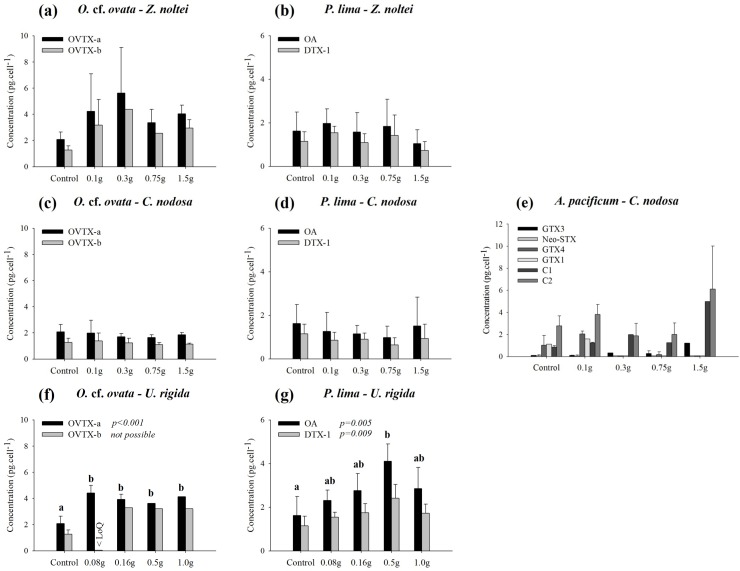
Cellular toxin contents (pg.cell-1) at the end of the experiments (after 10 days) of Ostreopsis cf. ovata (O. cf. ovata) and Prorocentrum lima (P. lima) in presence of the leaves/thalli of Cymodocea nodosa (C. nodosa), Zostera noltei (Z. noltei) and Ulva rigida (U. rigida), and of Alexandrium pacificum (A. pacificum) in presence of C. nodosa leaves.OVTX-a: Ovatoxin-a; OVTX-b: Ovatoxin-b; OA: Okadaic Acid; DTX-1: Dinophysistoxin-1; Neo-STX, GTX1, GTX3 and GTX4: Carbamoyl toxins; C1 and C2: N-sulfocarbamoyl toxins. ‘< LoD’ and ‘< LoQ’ indicate ‘< Limit of Detection’ and ‘< Limit of Quantification’, respectively. Error bars correspond to the standard deviation (N = 3 replicates, except for control (O. cf. ovata and P. lima) for which the controls of the three experiments have been pooled, N varying between 3 and 9 depending on the considered toxin). When only one among the three triplicates of each treatment was above LoD or LoQ, standard deviation was not calculable, and there is thus no error bar in such cases.